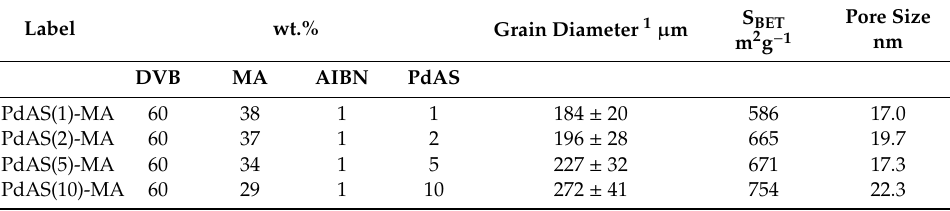
Table 1. Nominal composition of divinylbenzene (DVB), methyl acrylate (MA), 2,2 (cid:48) -azobis(2- methylpropionitrile) (AIBN) and N,N’-bis(3-allyl-salicylidene)o-phenylenediamine palladium(II) (PdAS), scanning electron microscopy (SEM) grain diameter, surface area and pore size for PdAS(x)-MA